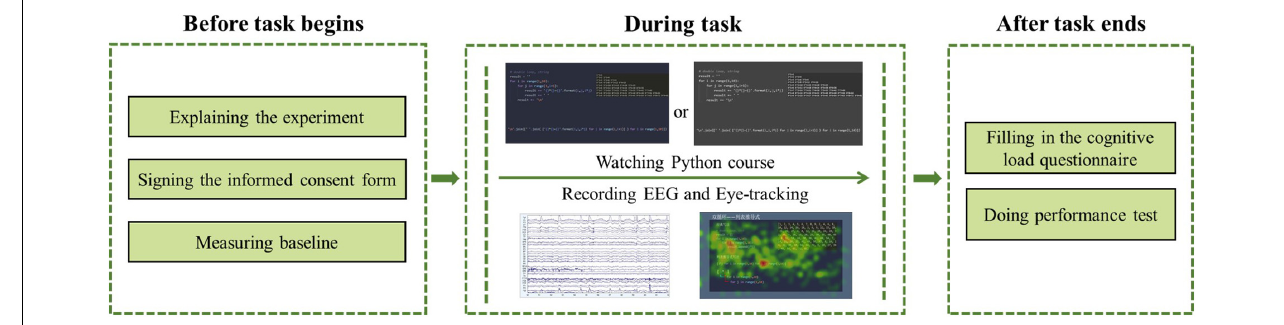
FIGURE 2 | Experimental procedure. The experiment used a between-subjects